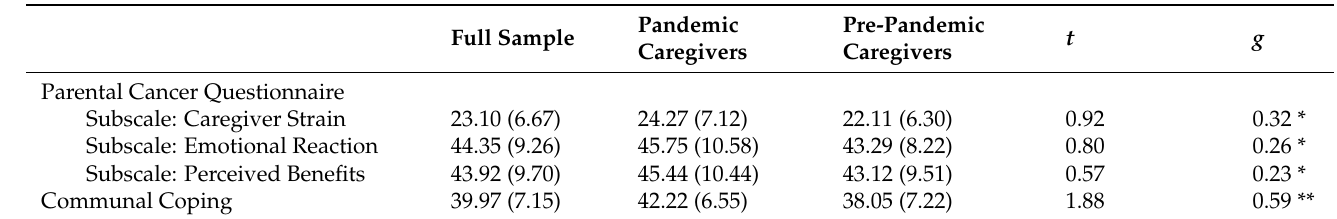
Table 2. Outcome Descriptives [ M ( SD )] and Group